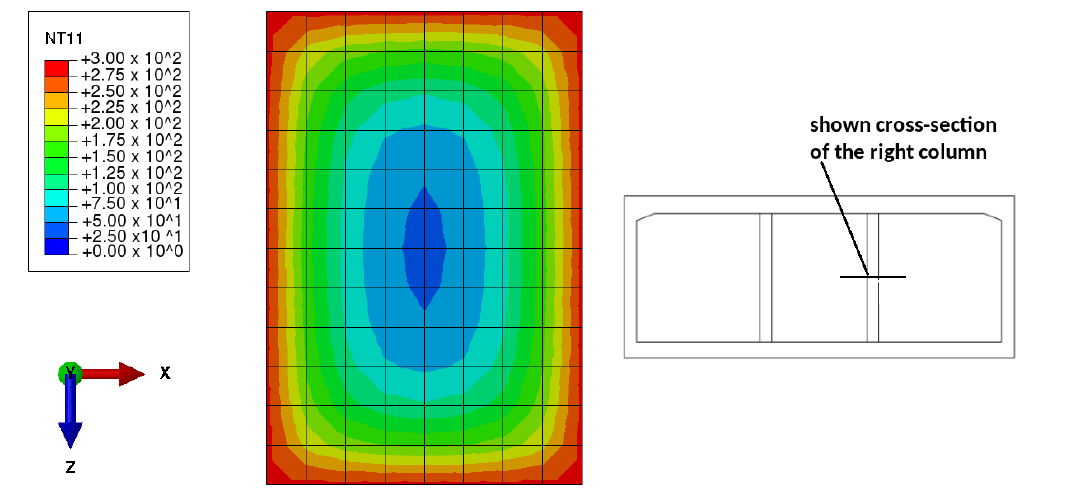
Figure 15. Temperature distribution obtained by prescribing three piecewise uniform surface temperature histories, 30 min after the start of the thermal loading: detail showing the central cross-section of the right